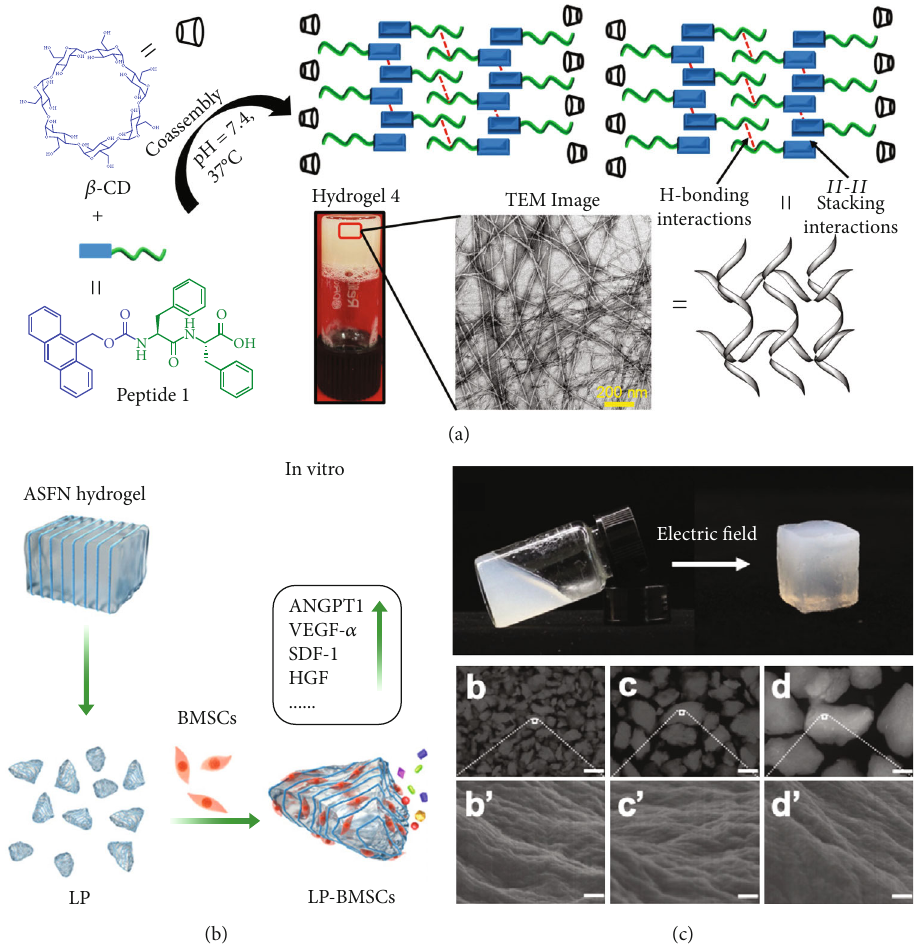
Figure 4: (a) Coassembly mechanism of thixotropic hydrogel. Nano fi bers are a result of stacking and hydrogen bonding interactions among the residues of the monomer. The properties of the hydrogel are tuned with the use of β -cyclodextrin, in order to obstruct the assembly structure, which allows the hydrogel to be injectable. (b) A silk fi broin hydrogel was loaded with mesenchymal stem cells and growth factors that would allow cellular di ff erentiation when bent in an in vivo model. (c) The hydrogel was separated with a molecular sieve, prepared under an electric fi eld. The results show that the material retains a hierarchical, aligned structure. These fi gures have been reproduced with permission from the American Chemical Society and John Wiley and Sons [65,